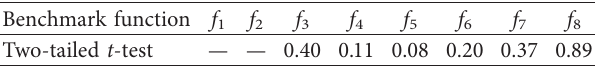
Table 4: Two-tailed t -test results from the comparison of the sequentialization model and the final all-GPU model on all the benchmark